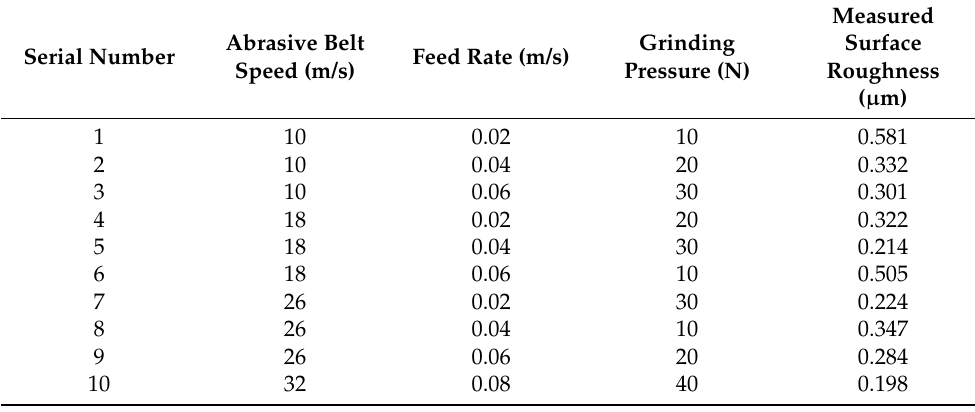
Table 5. Table of relative error of different prediction models.